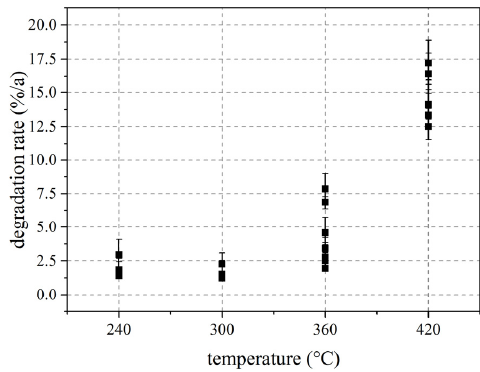
Figure 7. Degradation rate depending on temperature ( t = 72 h).